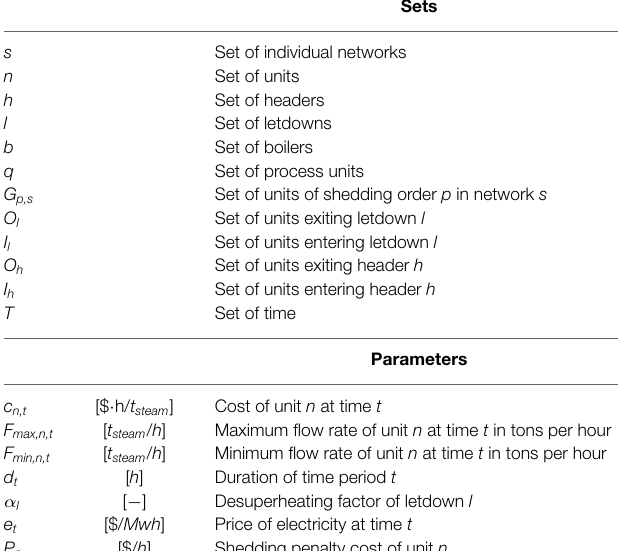
TABLE 5 | Notations of sets, parameters, and variables .